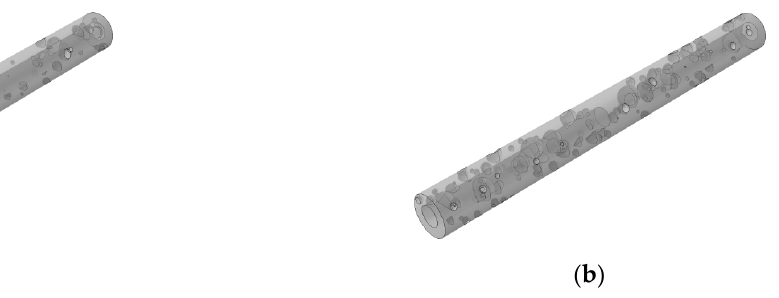
6 of 19 Figure 4. Schematic diagram of specimen. Table 1. Specimen dimensions. Specimens